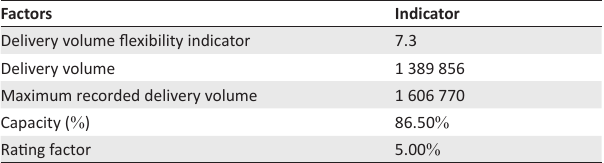
TABLE 18: Delivery volume flexibility.